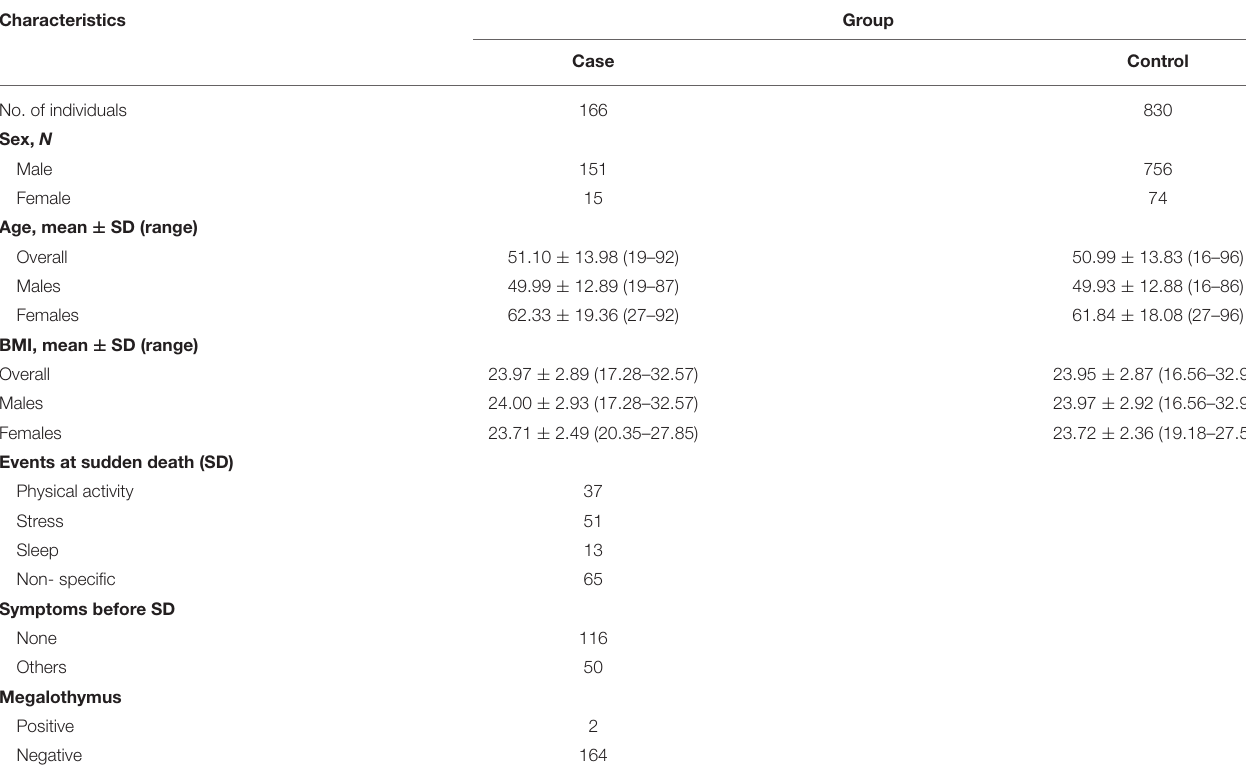
TABLE 1 | Clinical characteristics of SCD cases and controls.